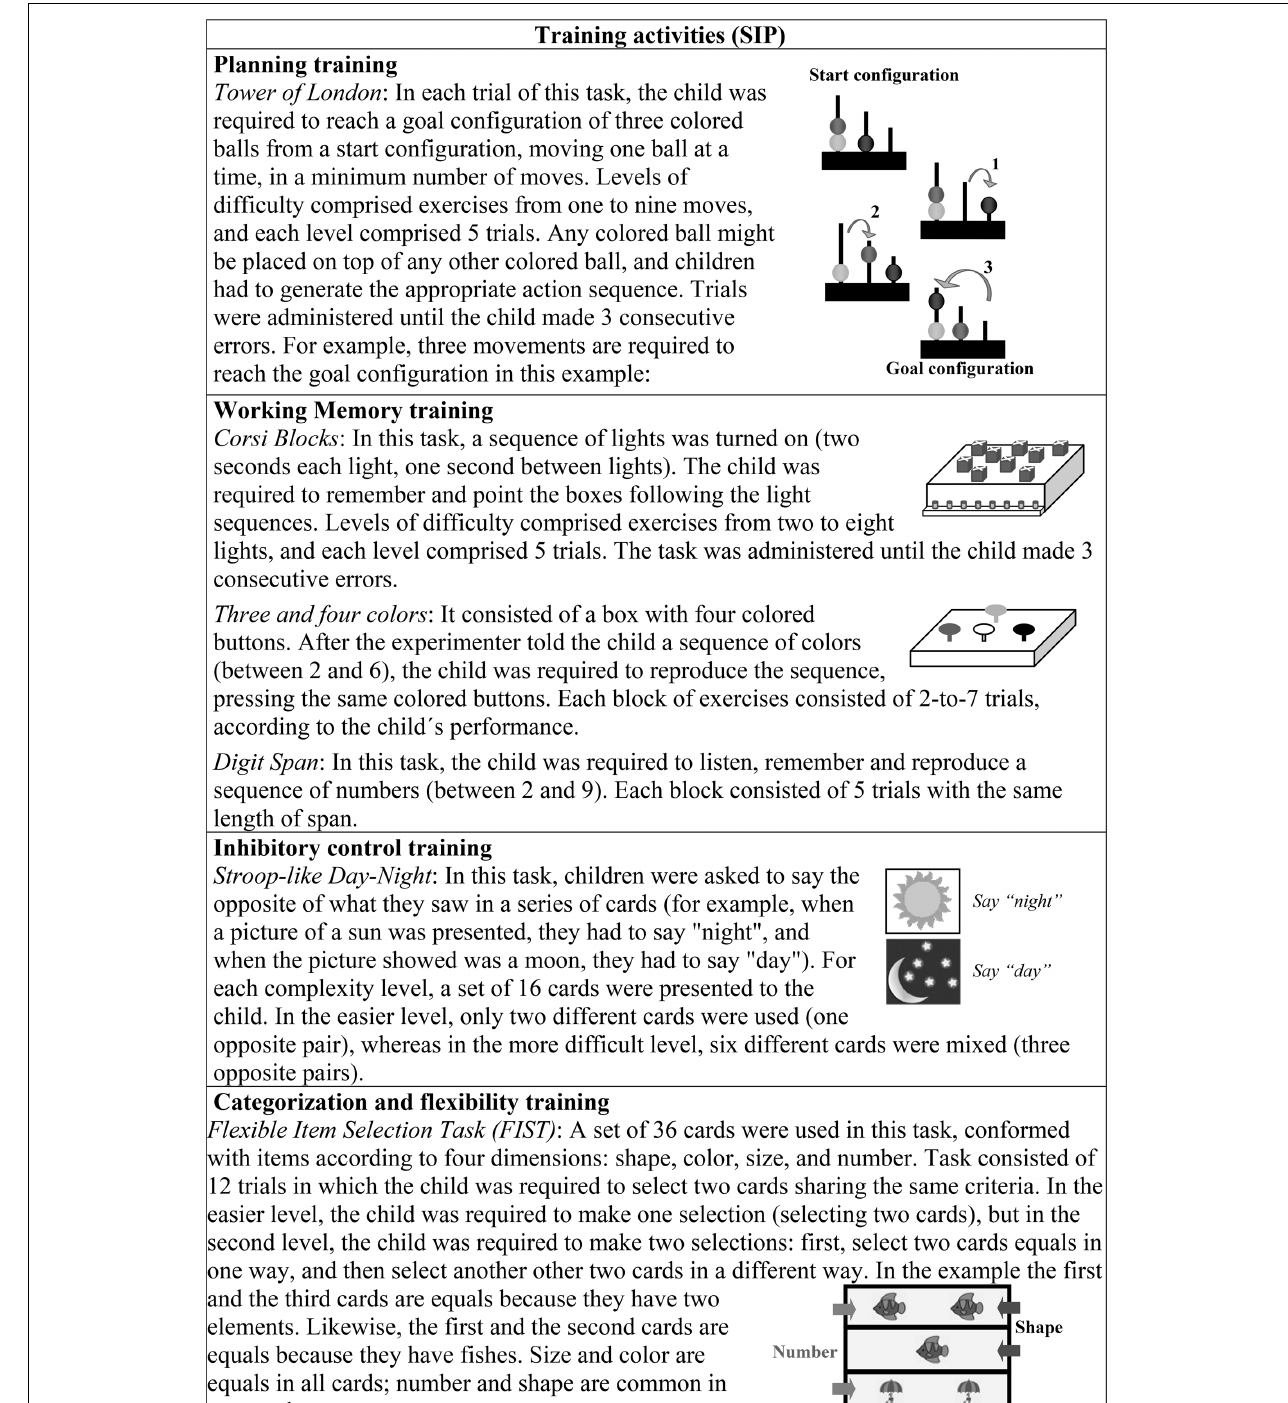
FIGURE 1 | Description of training activities in the